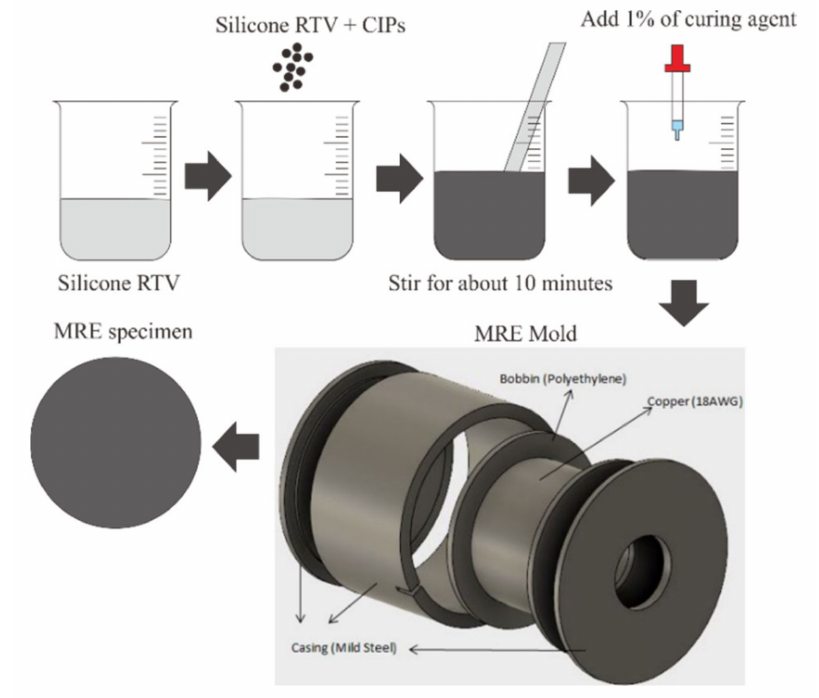
Figure 1. MRE sample